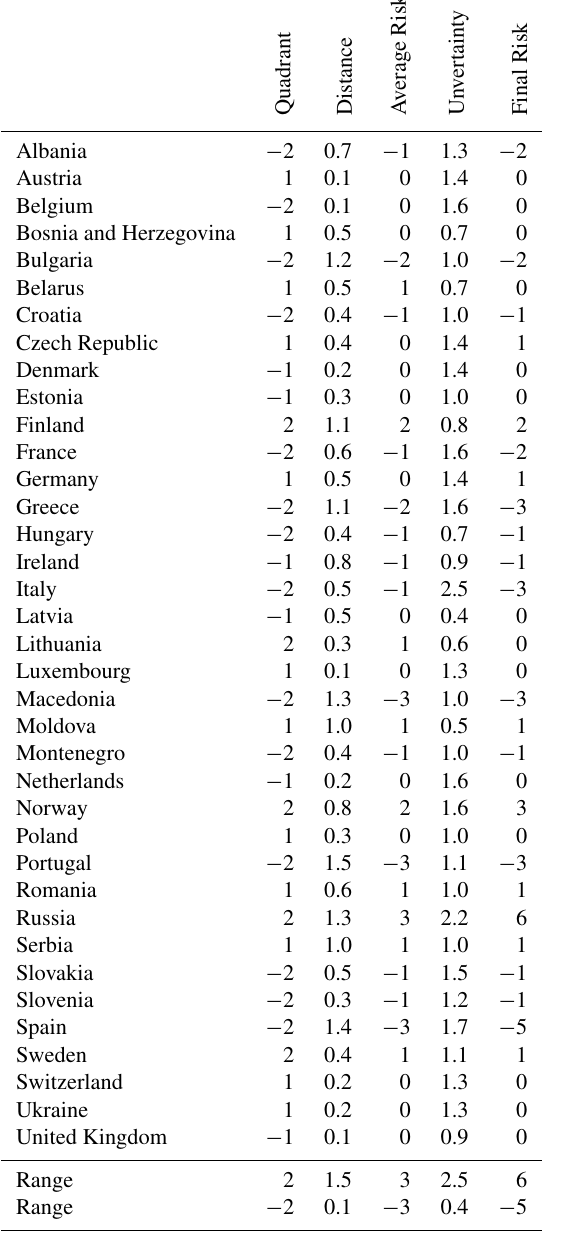
Table 2. Computation of the water scarcity risk index for emission scenario RCP4.5 in the long term (2060–2099)